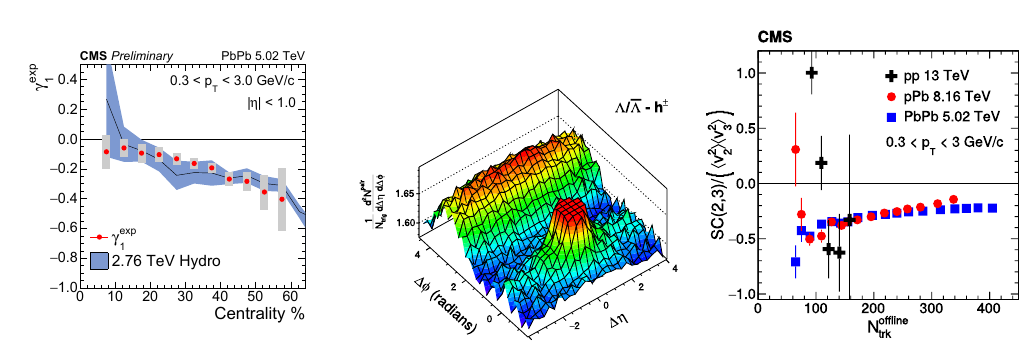
Figure 4. Left: the estimated skewness for the unfolded p ( v 2 ) in PbPb data at √ s NN = 5 . 02TeV, as a function of centrality [15]. Center: correlations between the hyperon and a charged hadron in high multiplicity pp collisions Figure 3. Left: R AA of prompt D 0 mesons and charged hadrons in pp and PbPb collisions at √ s NN = 5 . 02TeV, at √ s = 13TeV, as a function of ∆ η and ∆ φ [16]. Right: normalised symmetric cumulant between the second as a function of p T [12]. Center: example of simultaneous fit of the invariant mass spectrum and the v 2 , for the and third harmonics, as a function of the number of o ffl ine tracks, in pp, pPb and PbPb collisions [17]. extraction of the v 2 of prompt D 0 mesons in PbPb collisions at √ s NN = 5 . 02TeV [13]. Right: R AA of nonprompt J /ψ mesons as a function of the number of participants to the collision, at √ s NN = 2 . 76 [2] and 5.02TeV [3]. by a Bessel-Gaussian function. The skewness of the fluctuations, γ exp be in good agreement with predictions from an hydrodynamic model, as can be seen in Fig. 4. The decay channels used are D 0 K π and B ± J /ψ K. Similarly to J /ψ , they also include a non- → → prompt component from the decay of B mesons, which can be separated from the prompt component using the impact parameter of the D 0 meson decay vertex with respect to the primary vertex.